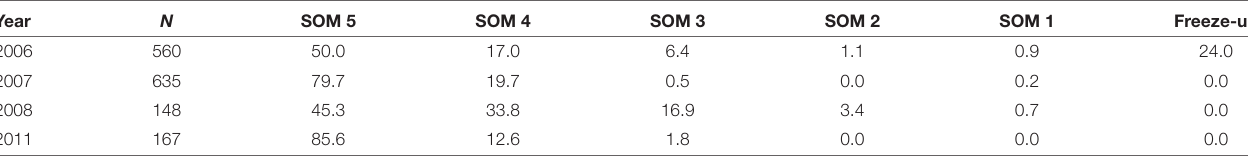
Refer to Table 2 for a description of SOM categories 1–5. The percentage of all individual observations for all ice types (N) is shown.